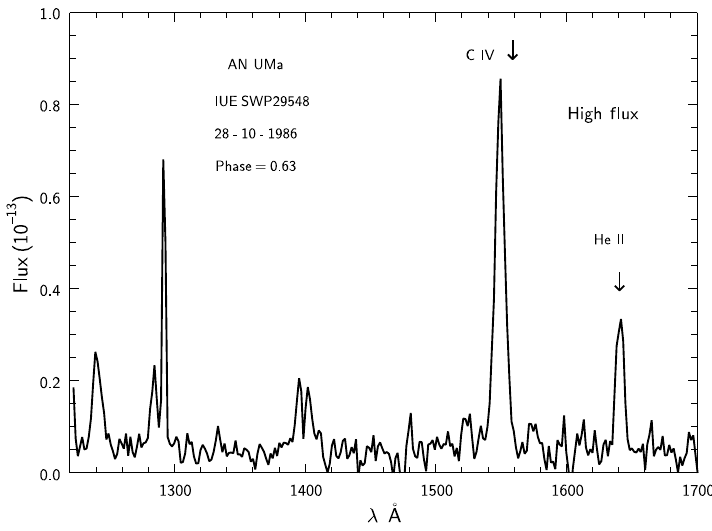
Fig. 2. IUE spectrum of AN UMa with high (cid:13)ux at phase 0.63. The (cid:13)ux is plotted in units of erg cm (cid:0) 2 s (cid:0) 1 (cid:23)A (cid:0) 1